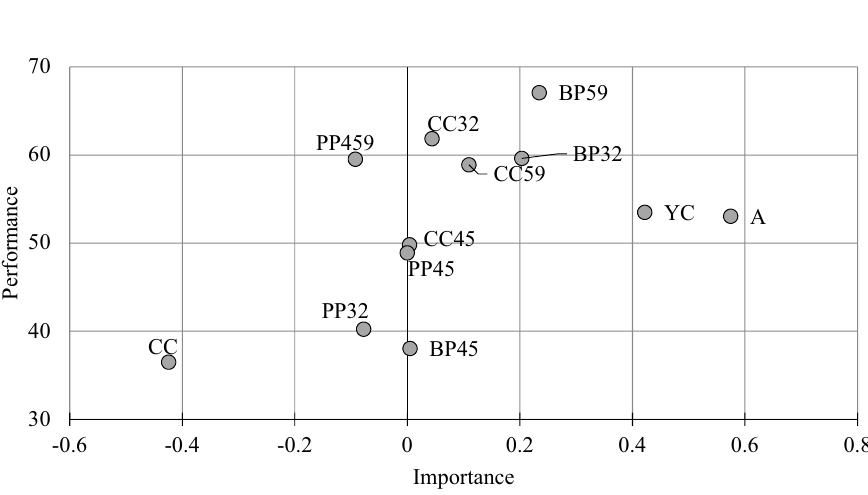
Figure 3. Importance-Performance Map Analysis presenting the impact of latent variables on biological yield (A—agronomic factors, YC—yield components, CC32, CC45, CC59—climate conditions in growth stages, PP32, PP45, PP59—physiological processes, BP32, BP45, BP59—biophysical parameters in the phenological stages of plant growth and development Z32, Z45 and Z59, CC—climate conditions for the entire growing